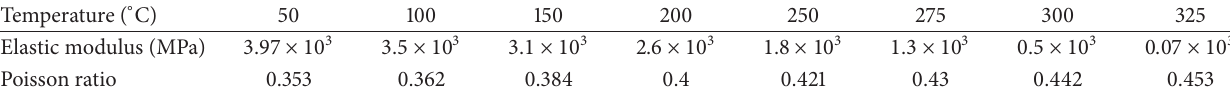
Table 2: Elastic modulus and Poisson ratio of laminates at different